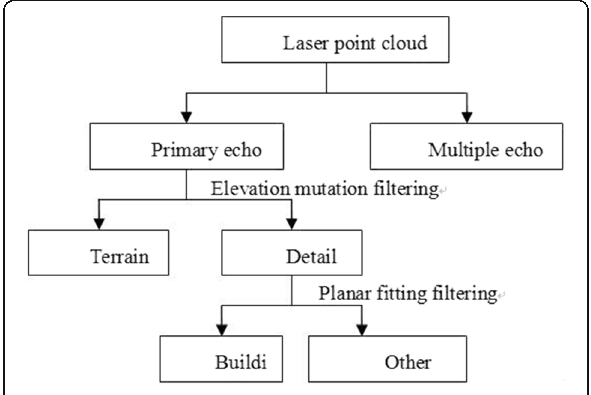
Fig. 1 Extraction process of building point cloud